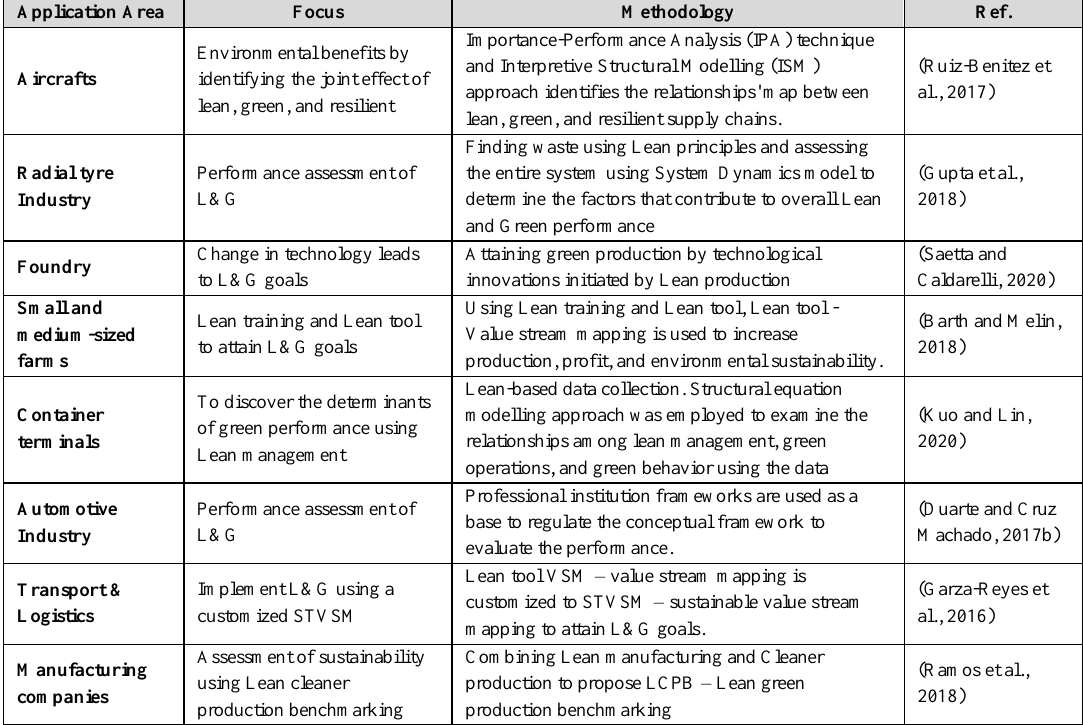
Table 2. Different application areas and their